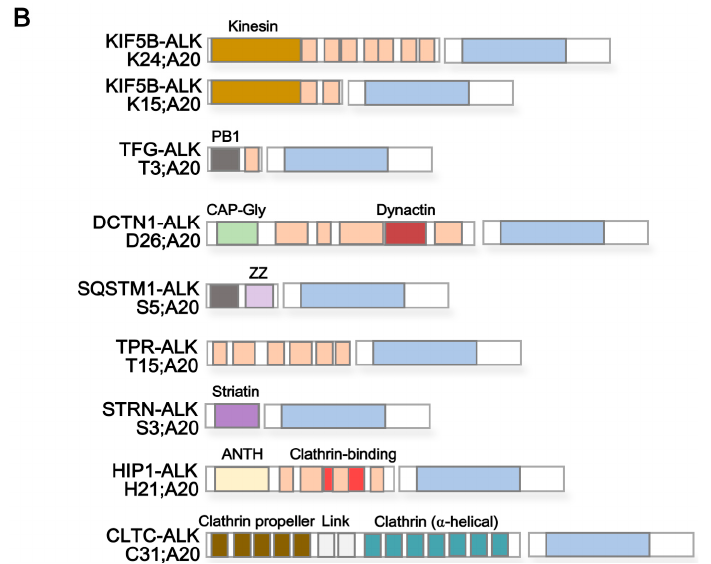
Figure 3. Schematic structural composition of ALK fusion proteins. ( A ) EML4-ALK fusion proteins. The breakpoint in the ALK gene is at exon 20; the breakpoint in EML4 is at different exons (e.g., 2, 6, 13, 14, 15, 18, and 20), resulting in variable EML4-ALK fusion proteins. In detail, variant 1 (E13;A20) and variant 2 (E20;A20) contain exons 1 to 13 and 1 to 20 of EML4, respectively, fused to exon 20 of ALK. Thus, the portion of EML4 includes its C-terminal coiled coil domain, HELP domain and parts of the WD repeat domain of EML4. Variant 3a/b EML4-ALK fusion proteins (E6a/b;A20) consist of exons 1 to 6 of EML4, with exon 6b being 188bp downstream of exon 6a, fused to exon 20 of ALK. Variant 4 (E14;E20) contain exons 1 to 14 of EML4, insertion of four amino acids of unknown origin, and fusion to exon 20 of ALK N-terminally lacking 49bp. Variant 5 EML4-ALK fusion proteins (E2a/b;A20) present a fusion of exon 2 of EML4 to exon 20 of ALK (E2a;A20) or to 117bp upstream of exon 20 of ALK (E2b;A20). Variant 6 (E13b;A20) contains exons 1 to 13 of EML4 fused to exon 20 of ALK with an insertion of 19 amino acids derived from upstream intron 19. Variant 7 (E14;A20) represents a genetic fusion of EML4 at exon 14 with ALK at exon 20, the latter lacking the first four amino acids. Variant “4” (E15;A20) is characterized as a fusion product of EML4 at exon 15 and ALK at exon 20. Variant “5” (E18;E20) consists of exons 1 to 18 of EML4 fused to exon 20 of ALK. ( B ) Other X-ALK fusion proteins. X represents any fusion partner including, amongst others, KIF5B-ALK (K24;A20 and K15;A20), TFG-ALK (T3;A20), DCTN1-ALK (D26;A20), SQSTM1-ALK (S5;A20), TPR-ALK (T15;A20), STRN-ALK (S3;A20), HIP1-ALK (H21;A20), and CLTC-ALK (C31;A20). For ( A ) and ( B ), protein domains are indicated by color and include: coiled coil (CC, light orange), HELP (dark orange), WD repeats (dark green), ALK kinase domain (blue), kinesin (ocher), PB1 (dark grey), CAP-Gly (light green), dynactin (dark red), zinc finger (ZZ, light violet), striatin (dark violet), ANTH (light yellow), clathrin-binding (light red), clathrin propeller (olive green), clathrin link (light grey), and clathrin (petrol) domains. Protein domains are derived from Pfam database [52]. See Table 1 for a list of ALK fusion partners and encoded protein